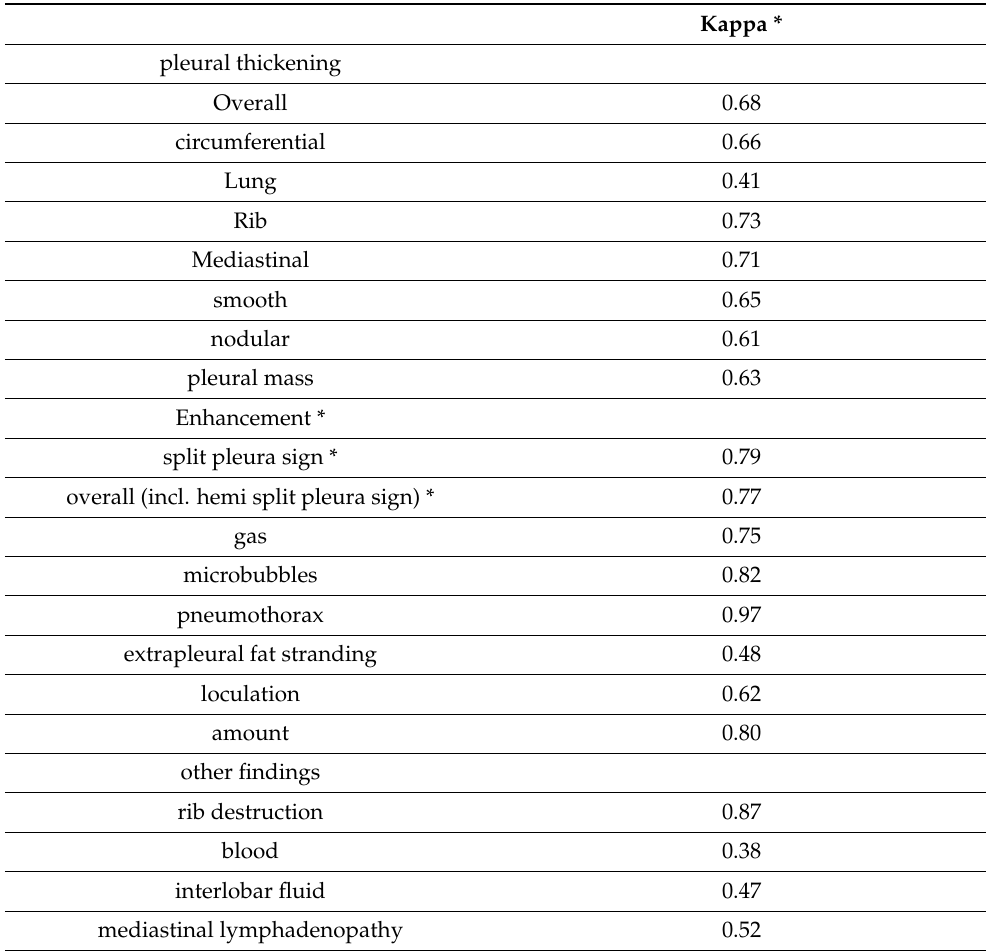
Table 1. Interrater